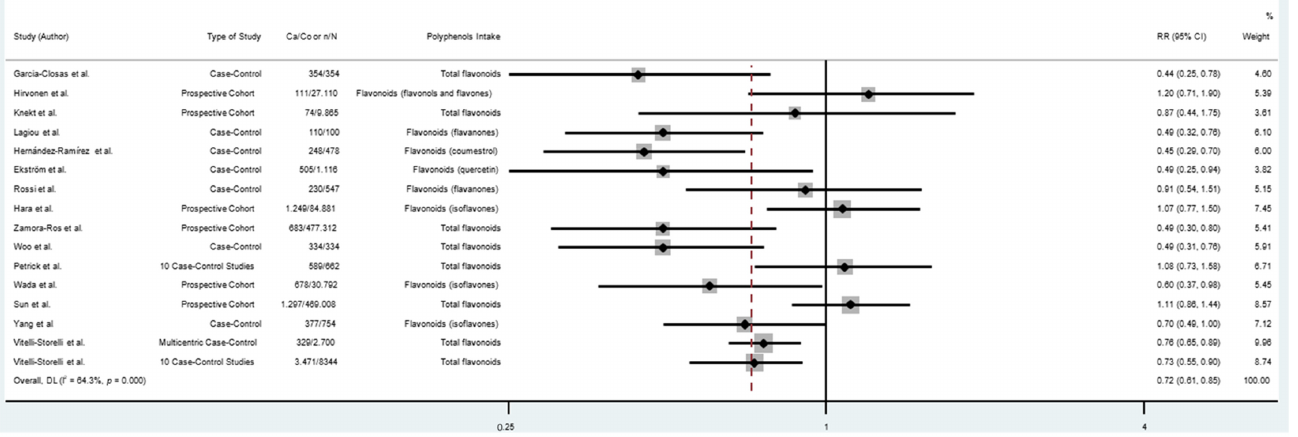
Figure 4. Forest plot of flavonoid consumption and gastric cancer risk. Case–control and cohort studies are presented in chronological order of publication. Square boxes represent study-specific estimates. Markers vary in size according to weight assigned to each study, size of each box reflects the study’s weight in the analysis, and horizontal lines represent 95% confidence intervals. Diamonds show the pooled effect. Abbreviations: RR, relative risk; Ca, number of cases; Co, number of controls; n, number of events; N, number of patients [4,5,8–14,16,25–27,29–31]. Cancers 2022 , 14 , x FOR PEER REVIEW